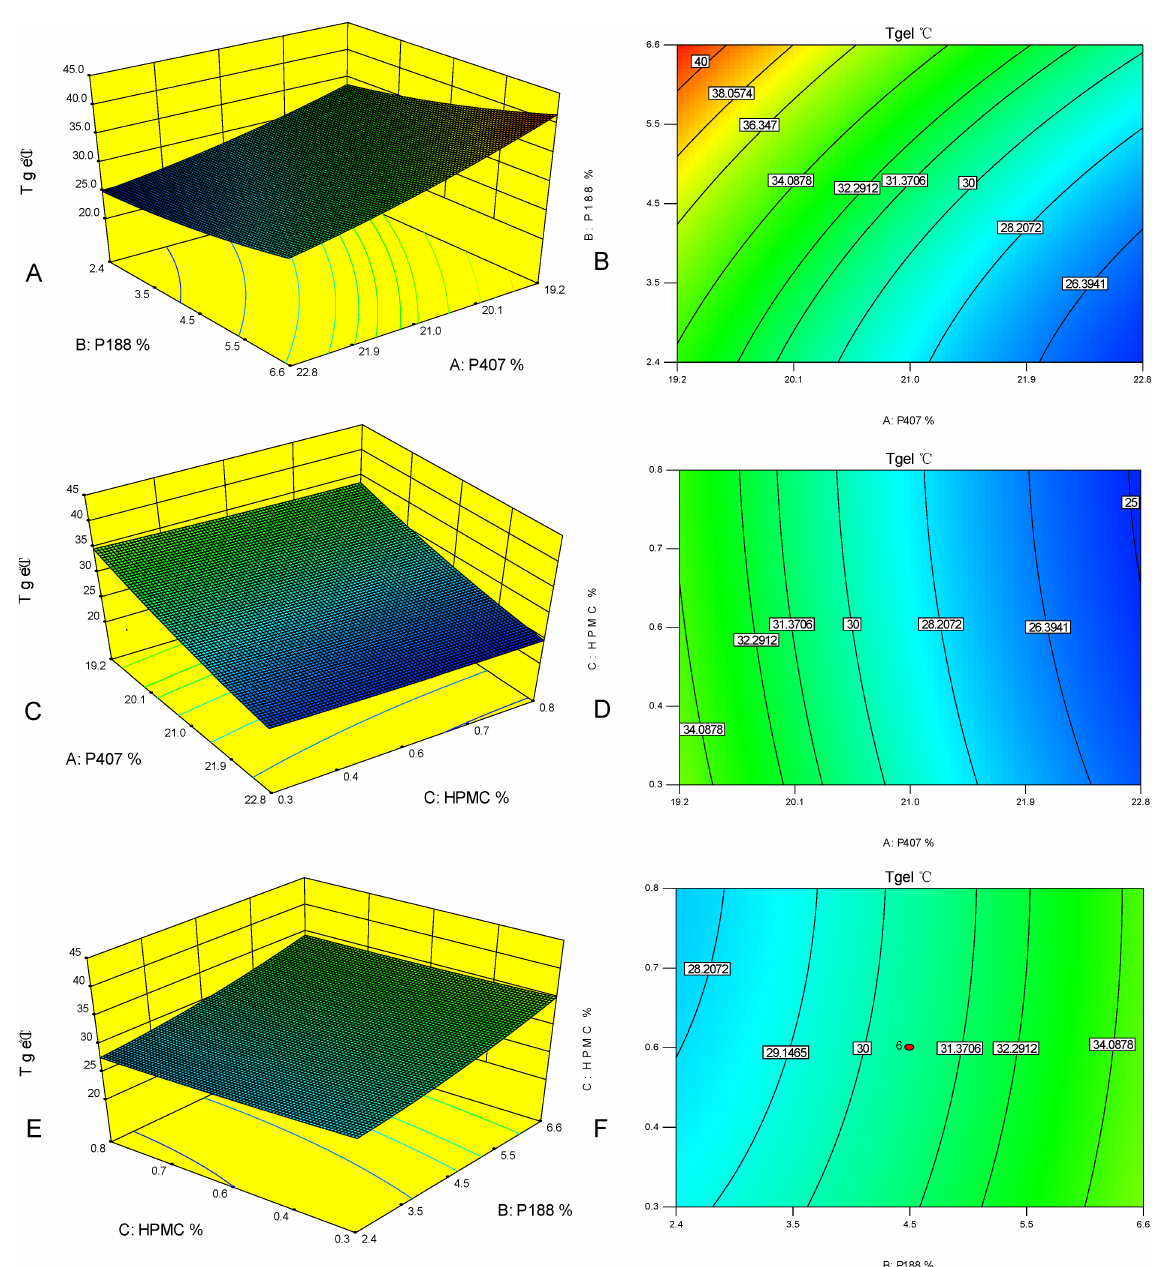
Fig 1. Three-dimensional surfacesand contours showing the influences of P407, P188 and HPMC. (A) 3D surface plot of P407 and P188 on Tgel (HPMC = 0.4%). (B) Contour of P407 and P188 on Tgel (HPMC = 0.4%). (C) 3D surface plot of P407 and HPMC on Tgel (P188 = 3.1%). (D) Contourof P407 and HPMC on Tgel (P188 = 3.1%). (E) 3D surface plot of P188 and HPMC on Tgel (P407 = 21.0%). (F) Contourof P188 and HPMC on Tgel (P407 = 21.0%). concentration of poloxamer188 was increased. When the concentration of poloxamer407 was (cid:21) 24% and the concentration of poloxamer188 was (cid:20) 2.0%, the gelation temperature of the for- mulation was < 25˚C. The formulation easily gelled during manufacturing and was unsuitable for administration. If the concentration of poloxamer407 was (cid:20) 18%, the gelation temperature of formulation was > 34˚C. The formulations couldn’t be used because they remained in liquid